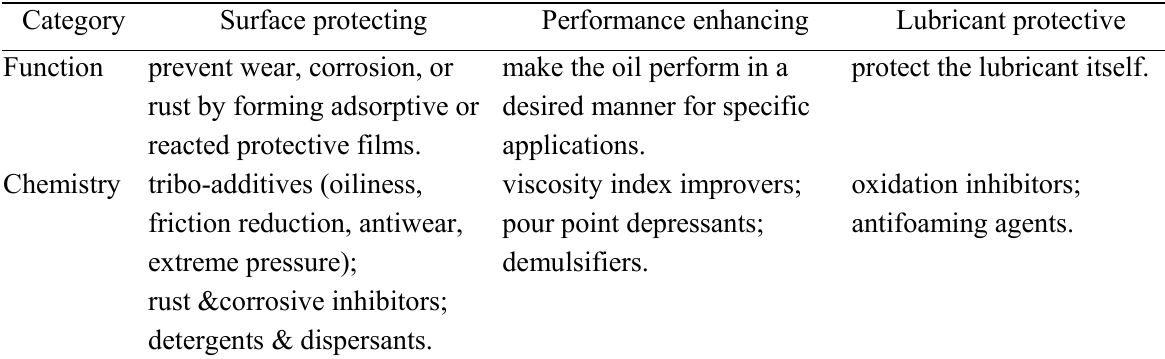
Table 3. Molecular chemistry of